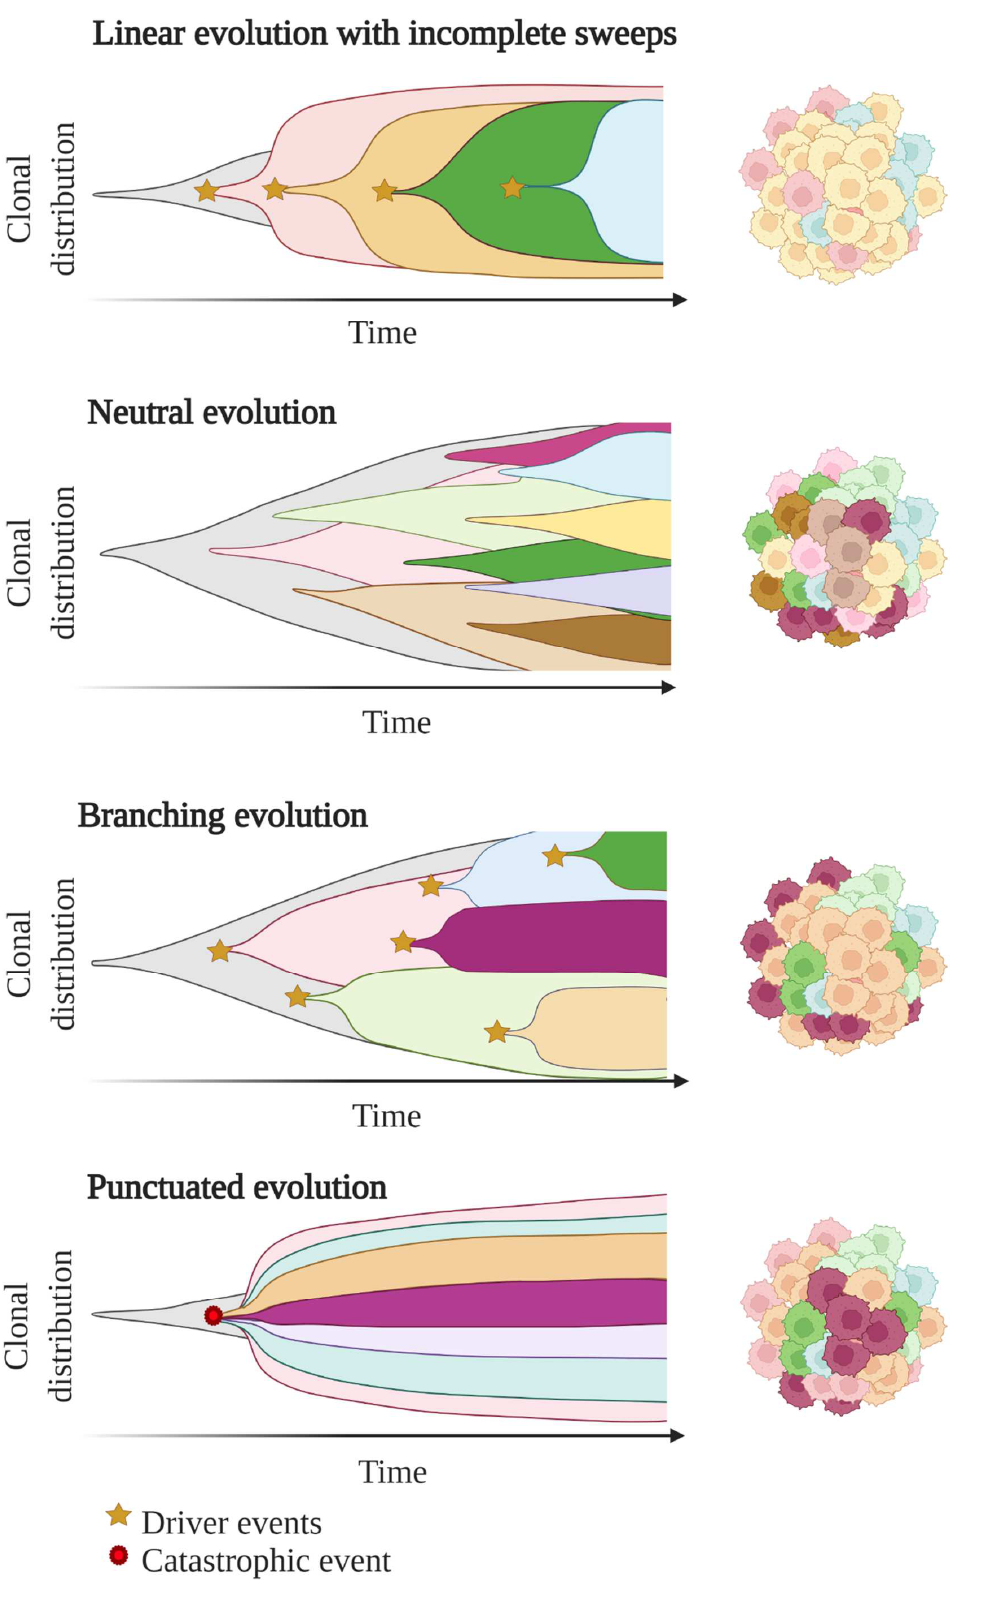
Figure 3. Models of tumour evolution described by Muller plots, which represent the tumour clonal dynamics over time. Colours indicate the different genotypes of the tumour cell